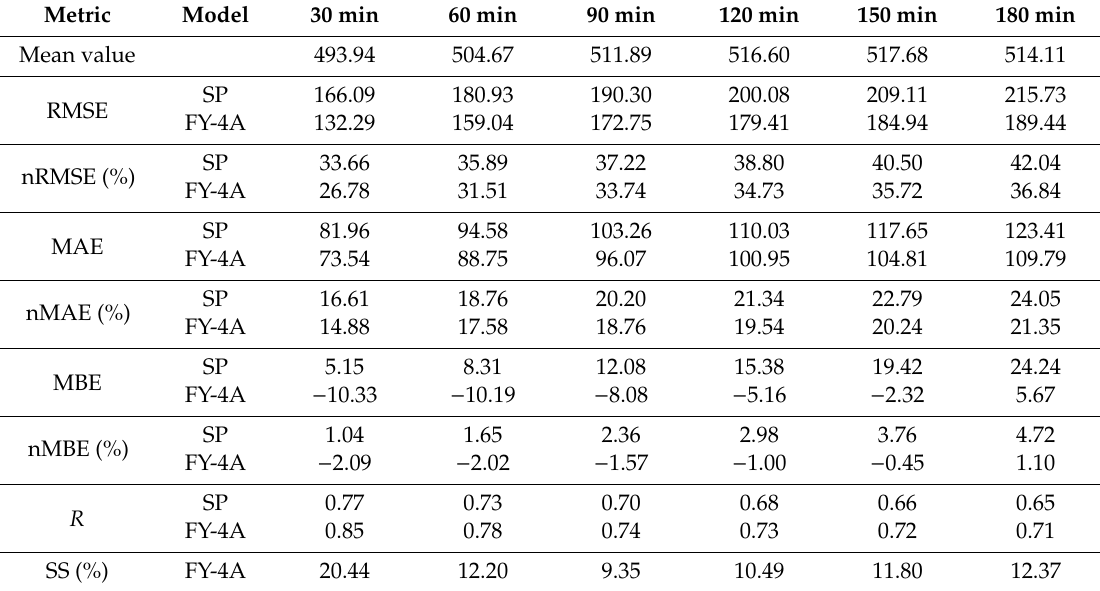
Table 1. Statistical indexes for GHI value from 30 to 180 min time horizons (W / m 2 for mean value, RMSE, MAE, and MBE).